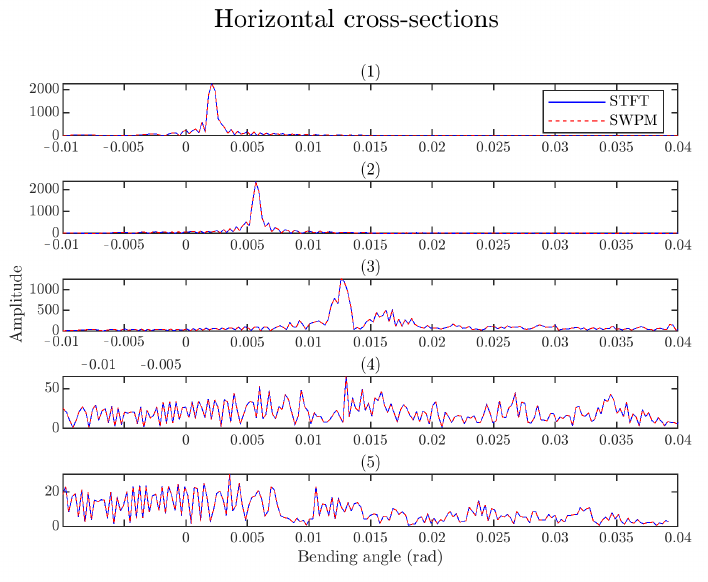
Figure 5. Five horizontal cross sections of STFT (solid blue) and SWPM (dashed red) applied to the same